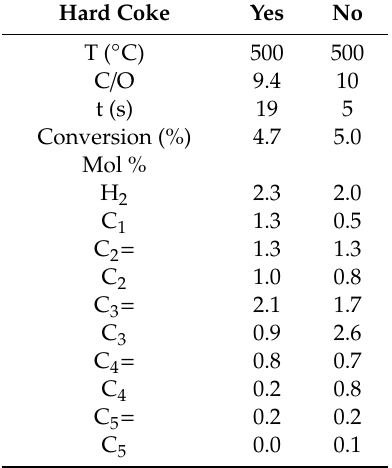
Table 3. Comparison of experimental results recorded with and without “hard coke” at the same conversion (di ff erent contact